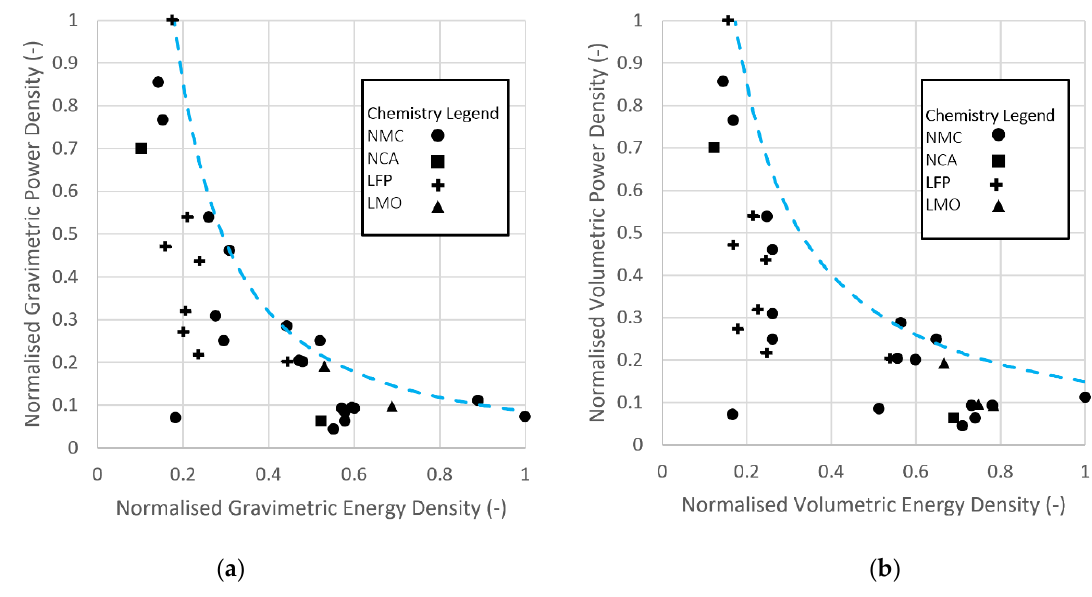
Figure 1. ( a ) Gravimetric and ( b ) volumetric Ragone plots for commercial state-of-the-art battery technology, including the Pareto front curve describing the power-to-energy-density trade-off.